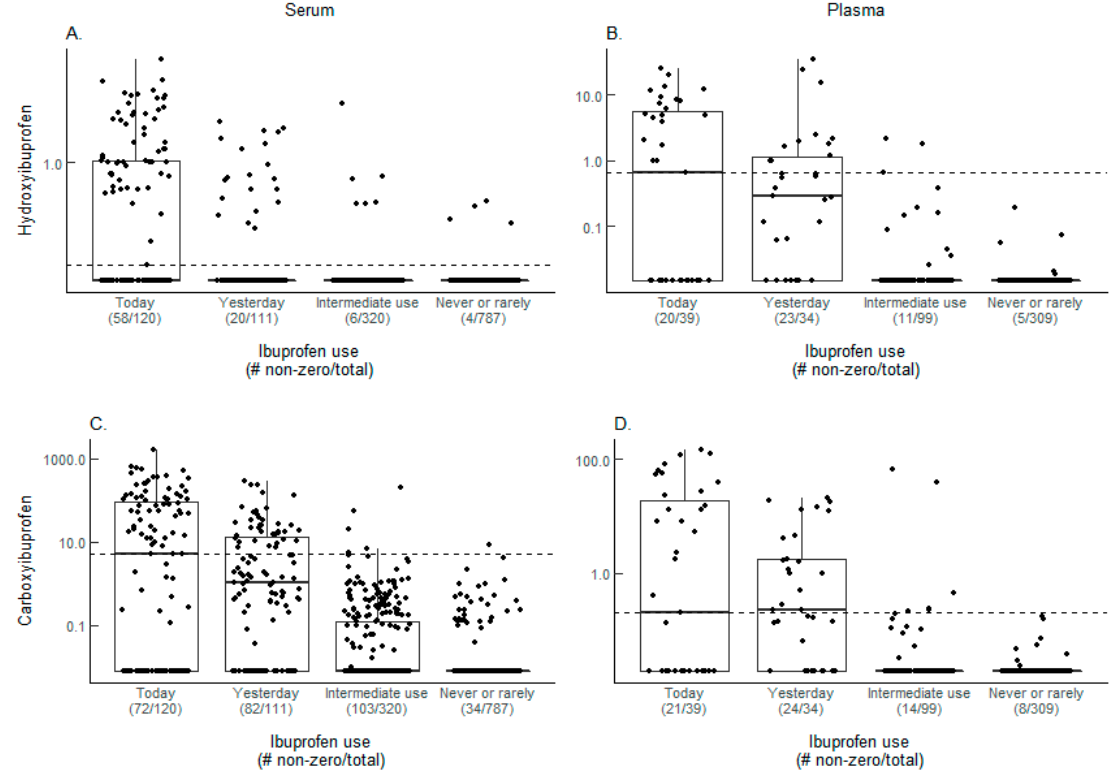
Figure 2. Ibuprofen metabolite levels. Box plots of ibuprofen metabolite levels from serum (women) and plasma (men) samples in log10 scale with undetected (zero) values adjusted to 80% of the minimum value detected for visualization purposes for ( A , B ) hydroxyibuprofen and ( C , D ) carboxyibuprofen. The cutoff levels used to define use for each metabolite are represented by the dashed lines and are ( A ) 0.2450, ( B ) 0.6487, ( C ) 4.9578, and ( D ) 0.2008. The number of samples with metabolites detected and the total number of samples analyzed are displayed beneath each self-reported use category.